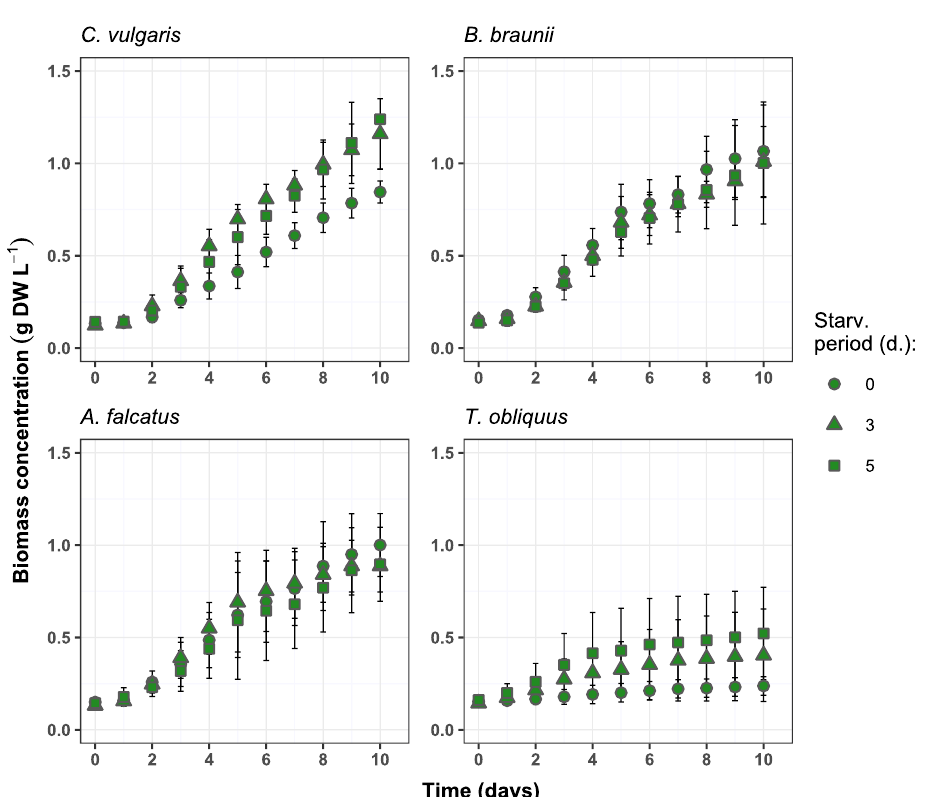
Figure 1. Biomass concentration changes over time in the experiment batches for C. vulgaris, B. braunii , A. falcatus and T. obliquus (means ± SD, n = 3).